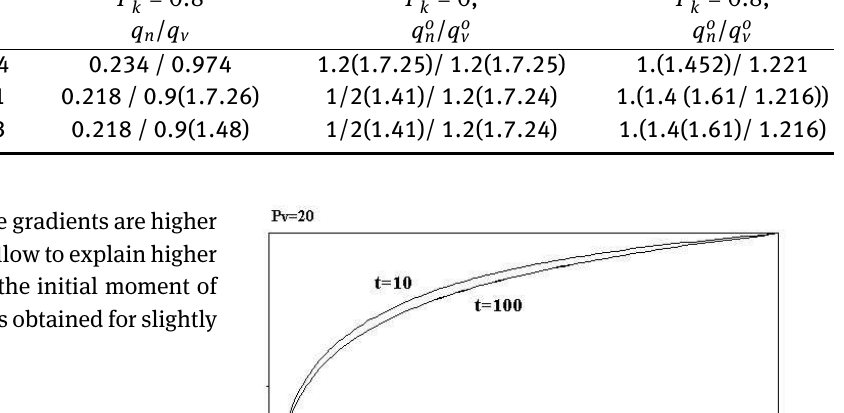
Table 3: Oil inflow into the well at the initial time